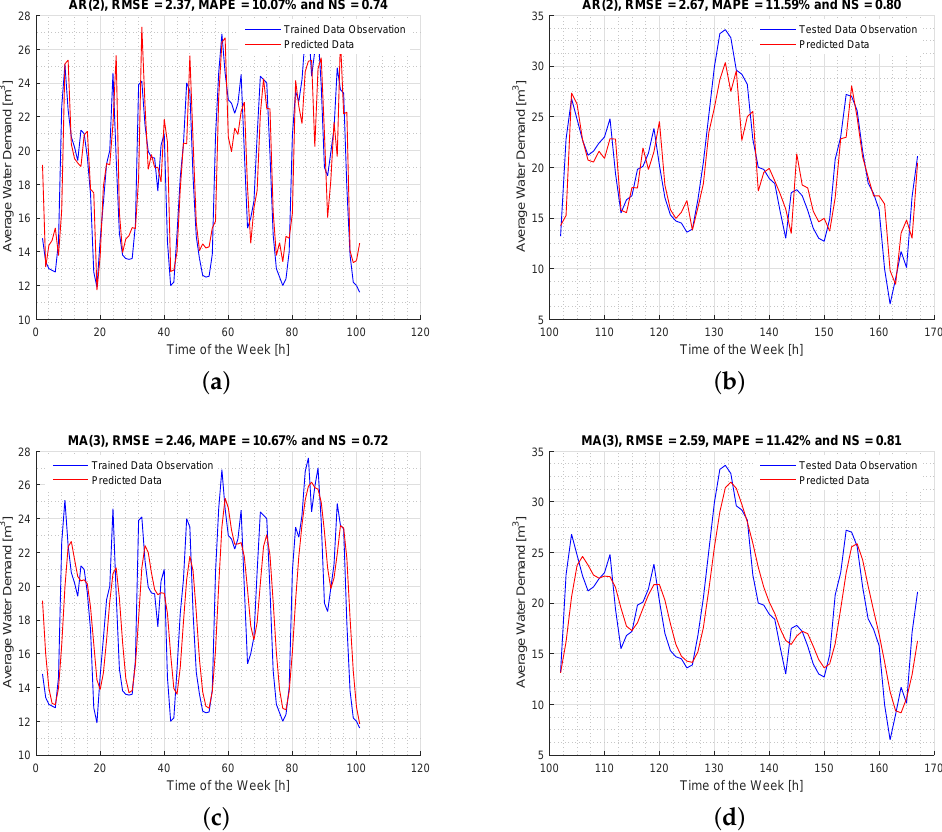
Figure 2. Forecasts generated using ( a , b ) AR model and ( c , d ) MA model. The best model orders, AR ( p = 2 ) and MA ( q = 3 ) , were determined based on Akaike information criterion (AIC) computation [40]. MAPE: mean absolute percentage error; NS: Nash–Sutcliffe; RMSE: root mean square